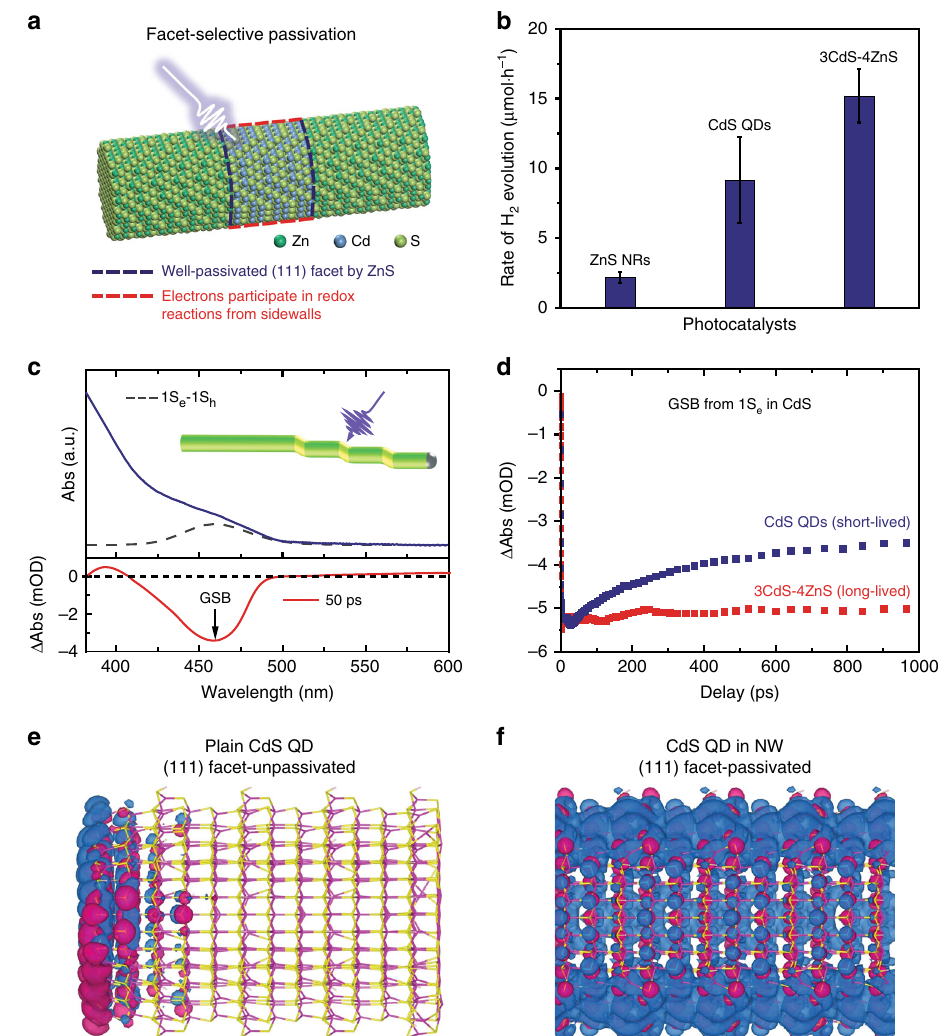
Fig. 4 Facet-selective passivation for photocatalytic hydrogen production. a Schematic of selective passivation of CdS (111) facets by ZnS segments, allowing photoexcited electrons to participate in redox reactions from sidewalls. b Photocatalytic hydrogen evolution rates of different photocatalysts, including Ag 2 S-tipped ZnS NRs, plain CdS QDs, and Ag 2 S-tipped 3CdS-4ZnS QDNWs. c (Upper panel) Absorption spectrum (blue solid line) and Gaussian- fi tted 1S e – 1S h exciton transition (grey dash line) of 3CdS-4ZnS QDNWs. (Bottom panel) A typical TA spectrum (red solid line) recorded at 50